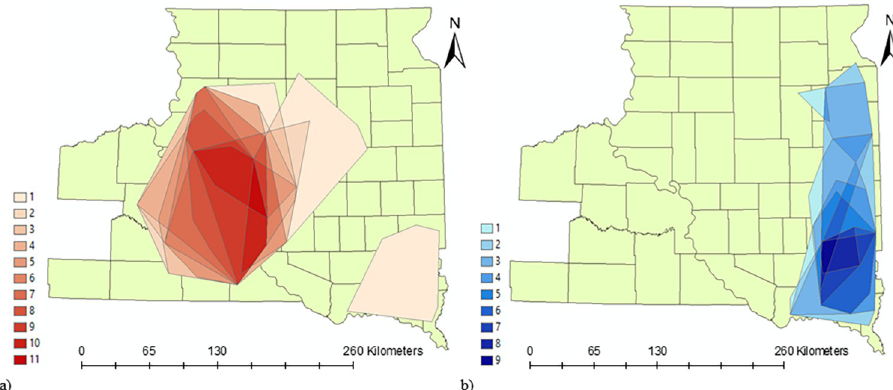
Fig 4. Areas under a) HotSpot and b) ColdSpot over an 11-year (2006–2016) period across the study area in South Dakota, USA. The legend shows the number of years an area was either a HotSpot or a